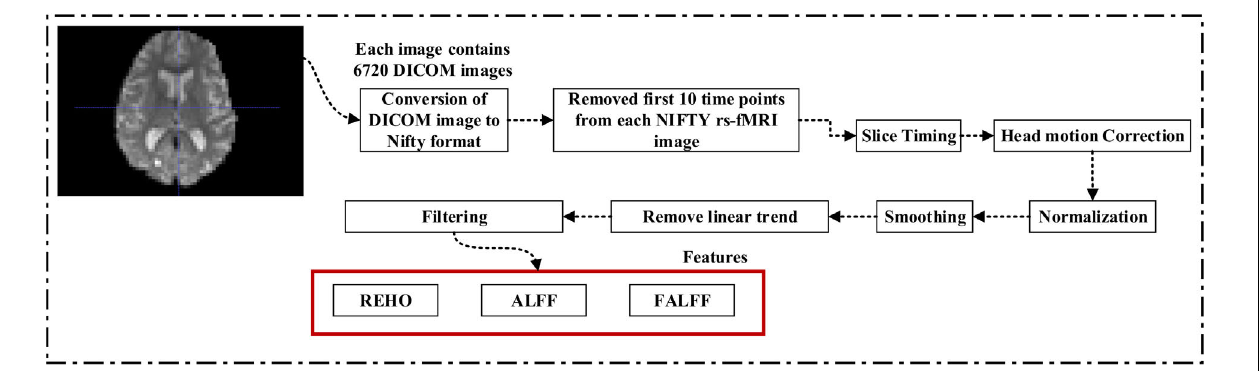
FIGURE 2 | Pipeline showing feature extraction process for rs-fMRI